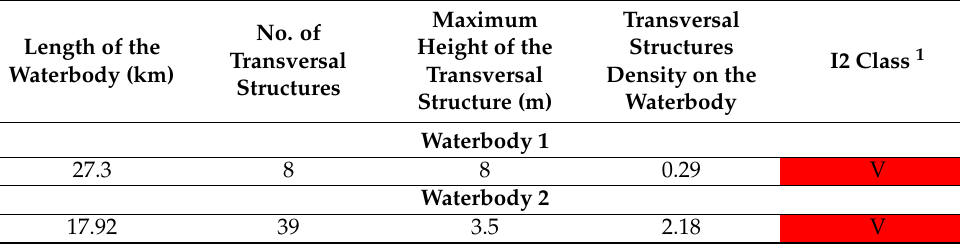
Table 6. The results of the indicator longitudinal continuity/connectivity of the riverbed (waterbody level).